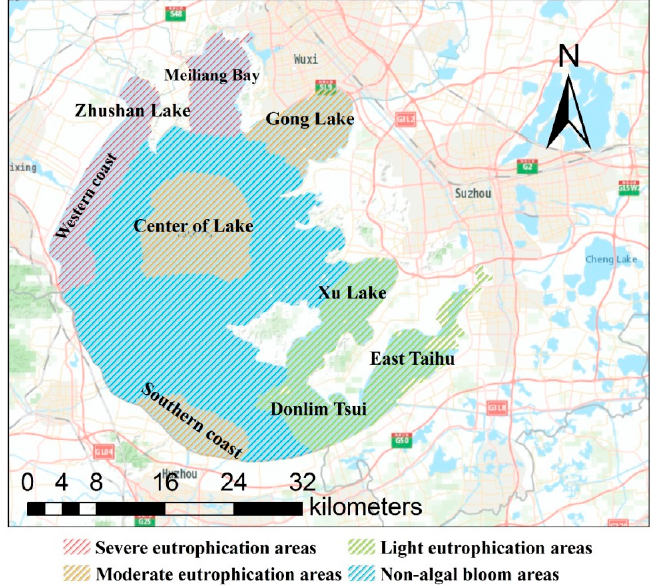
Figure 5. Different eutrophication areas of Taihu Lake.